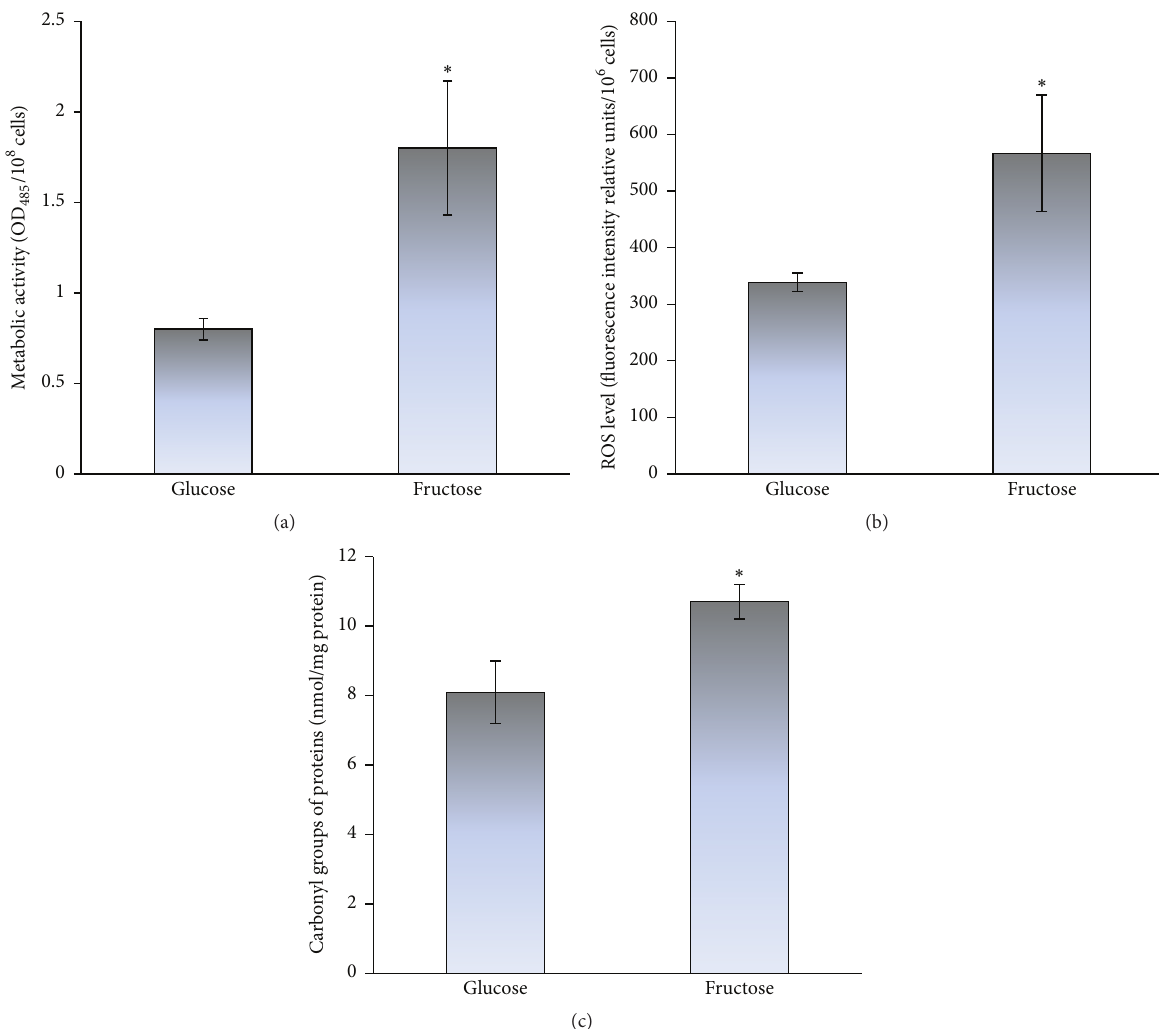
Figure 1: The metabolic rate (a) and level of oxidative stress markers: ROS (b) and protein carbonyls (c), in glucose- and fructose-grown S. cerevisiae YPH250. Results are shown as the mean ± SEM ( 𝑛 = 3 – 6 ). ∗ Significantly different from respective values for glucose with 𝑃 < 0.05